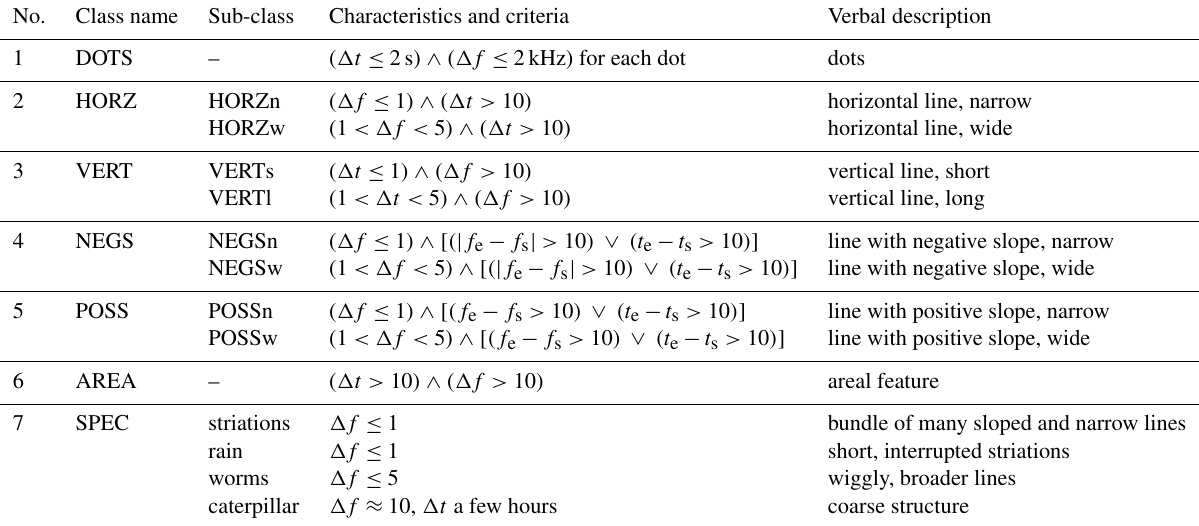
Table 1. Summary table for seven different classes of SKR fine structures. The first column contains the number of the class and the second column contains its name in a four-letter abbreviation. The third column denotes sub-classes: vertical lines (VERT) can be short (VERTs) or long (VERTl) in duration. Horizontal lines (HORZ) and lines with negative (NEGS) or positive (POSS) slope can be narrowbanded ( n ) or widebanded ( w ). The fourth column contains a detailed characteristic of the features in mathematical terms where (cid:49)f denotes the bandwidth, (cid:49)t denotes the time duration, f e and f s are the end and start frequency, and t e and t s are the end and start time, respectively. For frequencies, the unit is kHz and for times, the unit is seconds (only indicated for DOTS class). Finally, the fifth and last column contains a verbal description for each